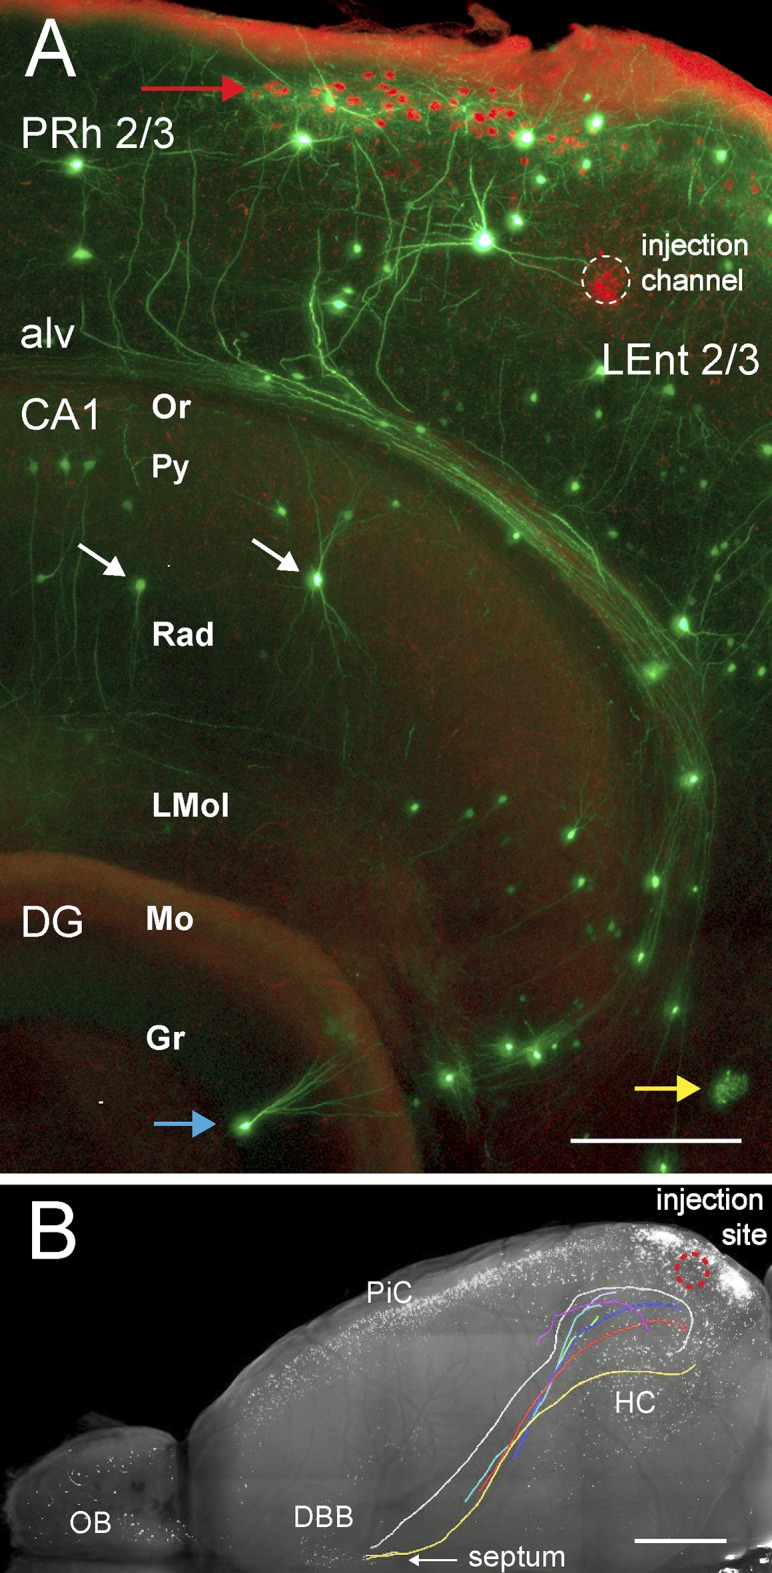
Neuronal cells and neurites in the ipsilateral injected EC/hippocampal area.Brain sample same as Fig 4; original dataset (LSFM recording, horizontal): same as Fig 4. (A) Green/red overlay of LSFM 50 μm z range maximum projections from a subvolume of the EC/HC area. Green channel: RABVΔG-EGFP fluorescence revealing different cell types with dendrites and axon bundles. Red channel, rAAV-labeled cells (red arrow) below the brain periphery, which shows red autofluorescence. Dotted circle encloses the red fluorescence of the injection channel, which runs almost perpendicular to the image plane. White arrows, interneurons; blue arrow, granule cell; yellow arrow, glia cell. PRh 2/3, layers 2/3 of perirhinal cortex; alv, alveus of the hippocampus; CA1, Ammons Horn field CA1; Or, oriens layer; Py, pyramidal cell layer; Rad, radiatum layer; LMol, lacunosum moleculare; DG, dentate gyrus; Mo, molecular layer, Gr, granular layer; LEnt 2/3, layers 2/3 of lateral entorhinal cortex. Colors representing fluorescence signals were partially desaturated with Adobe Photoshop. Scale bar, 200 μm. (B) Long-range axonal projections traced in 3D with KNOSSOS and overlaid onto a green channel maximum z projection rendered as greyscale (cf. Fig 4C, top panel). Colored axon trajectories were generated with Amira from 3D KNOSSOS datasets. Arrow points to septum. Scale bar, 1 mm.